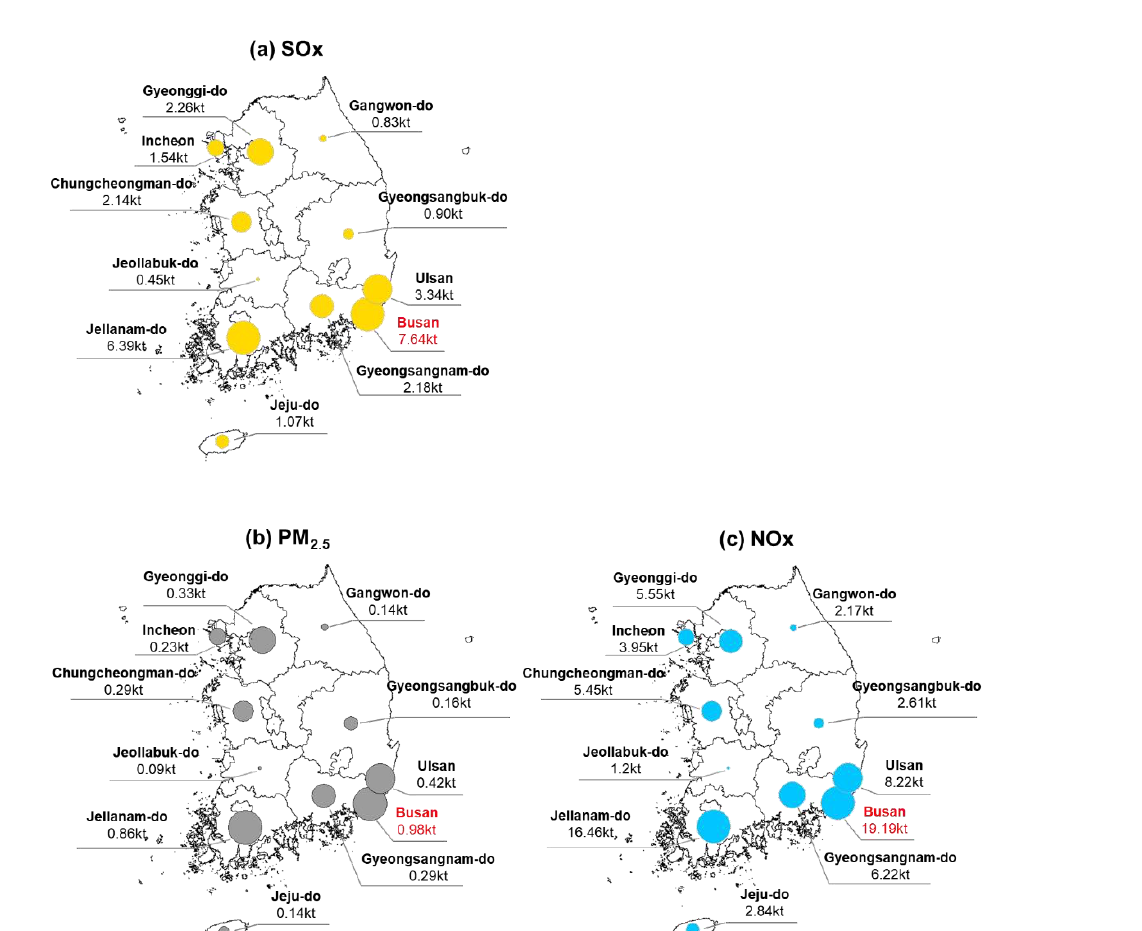
Figure 5. CAPSS2016 ratios by emission sources for ( a ) SOx, ( b ) PM 2.5, and ( c ) NOx in Busan.